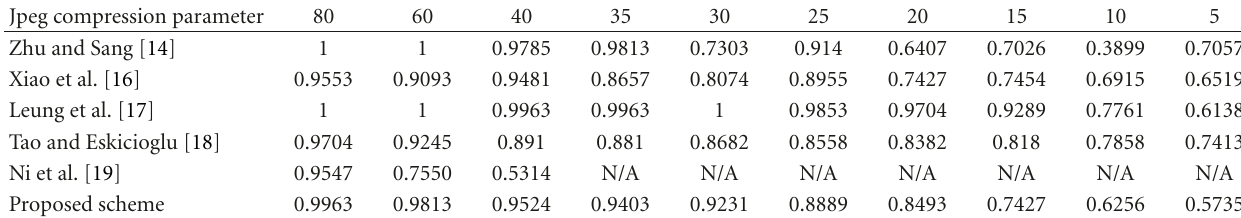
Table 5: Experiment results comparison under Jpeg compression (NC values).